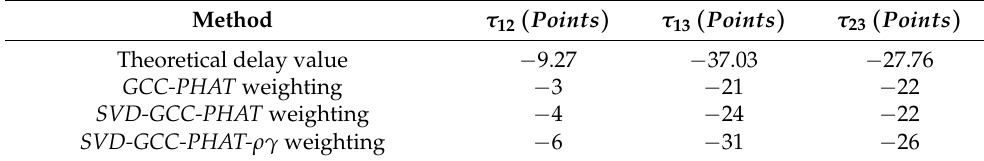
Table 2. Comparison of results of different time delay estimation methods.